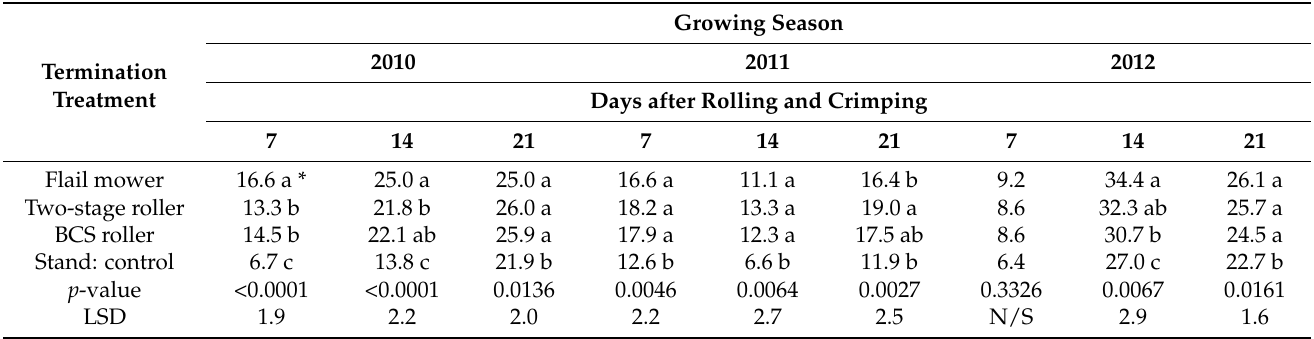
Table 11. Volumetric soil water content (VMC in %) for cereal rye during three weeks of evaluation for three growing